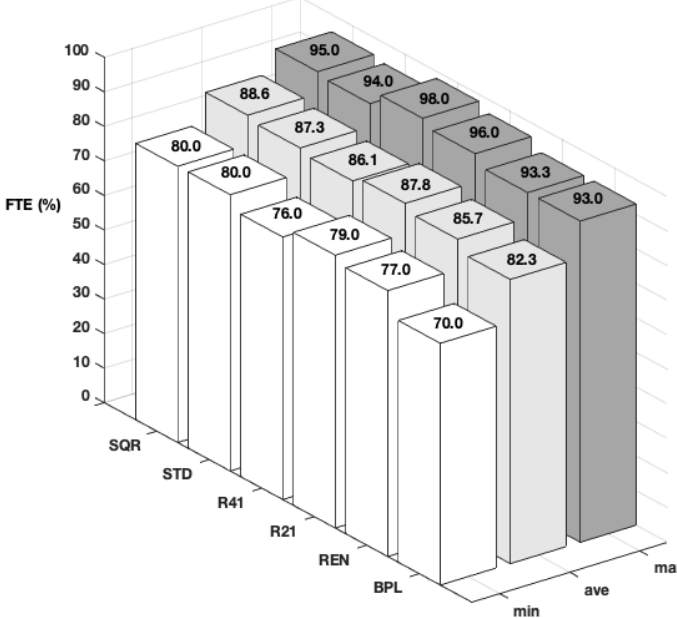
Figure 10. The minimum (min), average (ave), and maximum (max) field traversing efficiency (FTE) for each template field. Table 3. The scenarios for min, max computed FTE in each test field.